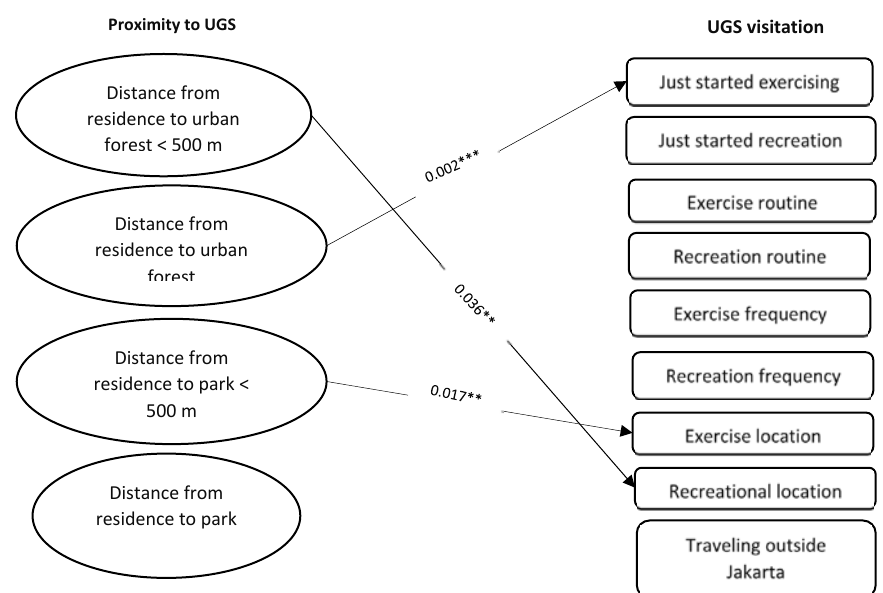
Fig. 5: The patterns of direct correlations between residential proximity to UGS and motivations for UGS visitation (** p < 0.05; *** p < 0.01)